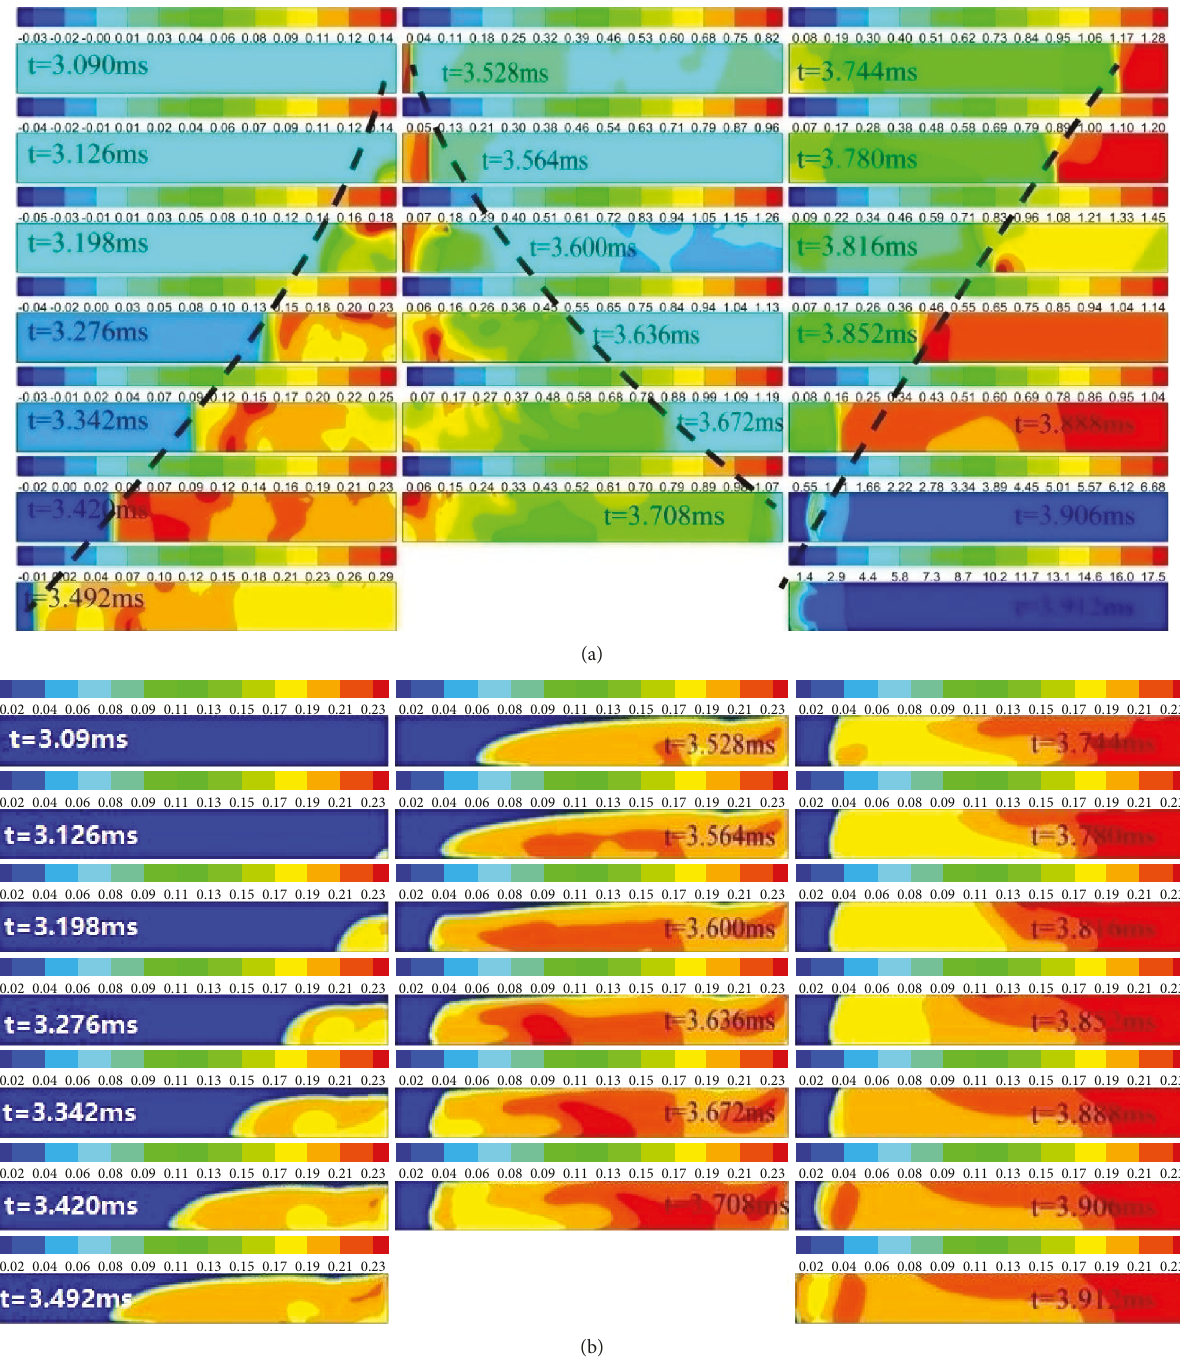
Figure 18: Propagation of wave and fl ame in the WRC channel under operating conditions of BR = 0 : (a) propagation of wave and (b) propagation of fl